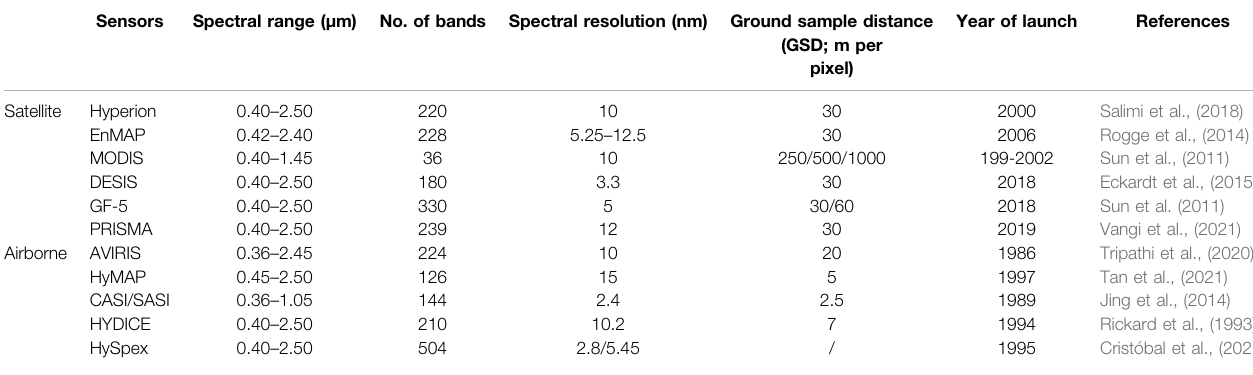
TABLE 1 | Widely used hyperspectral